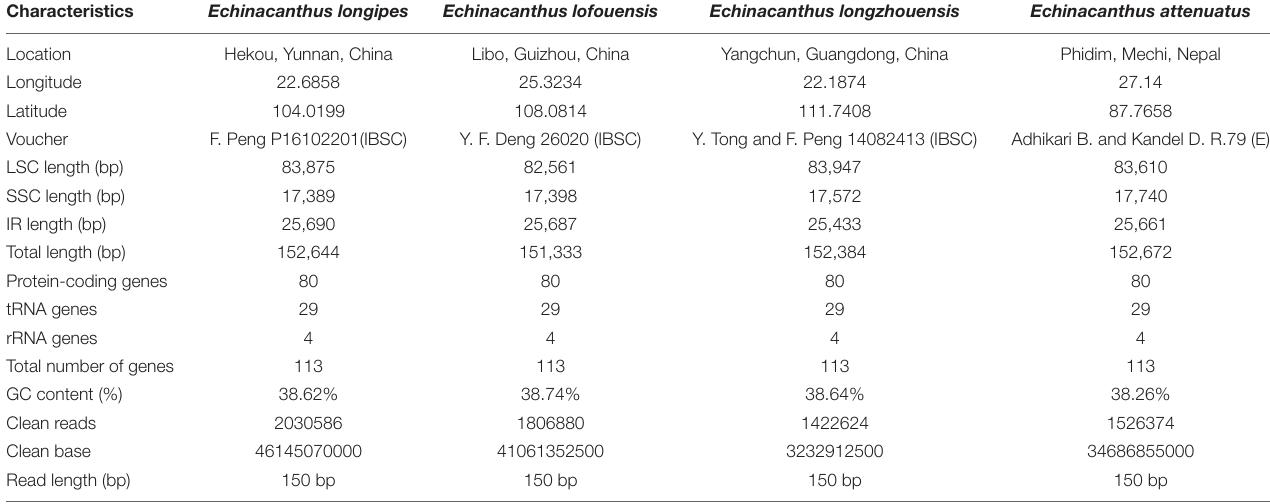
TABLE 1 | The basic characteristics of the chloroplast genomes of four Echinacanthus species. Characteristics